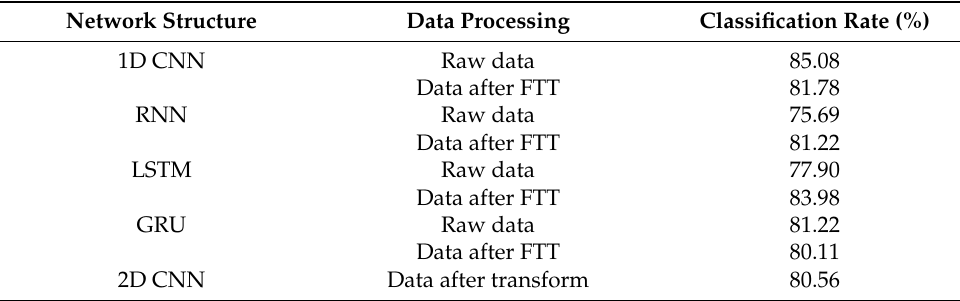
Table 4. Comparison of different machine learning